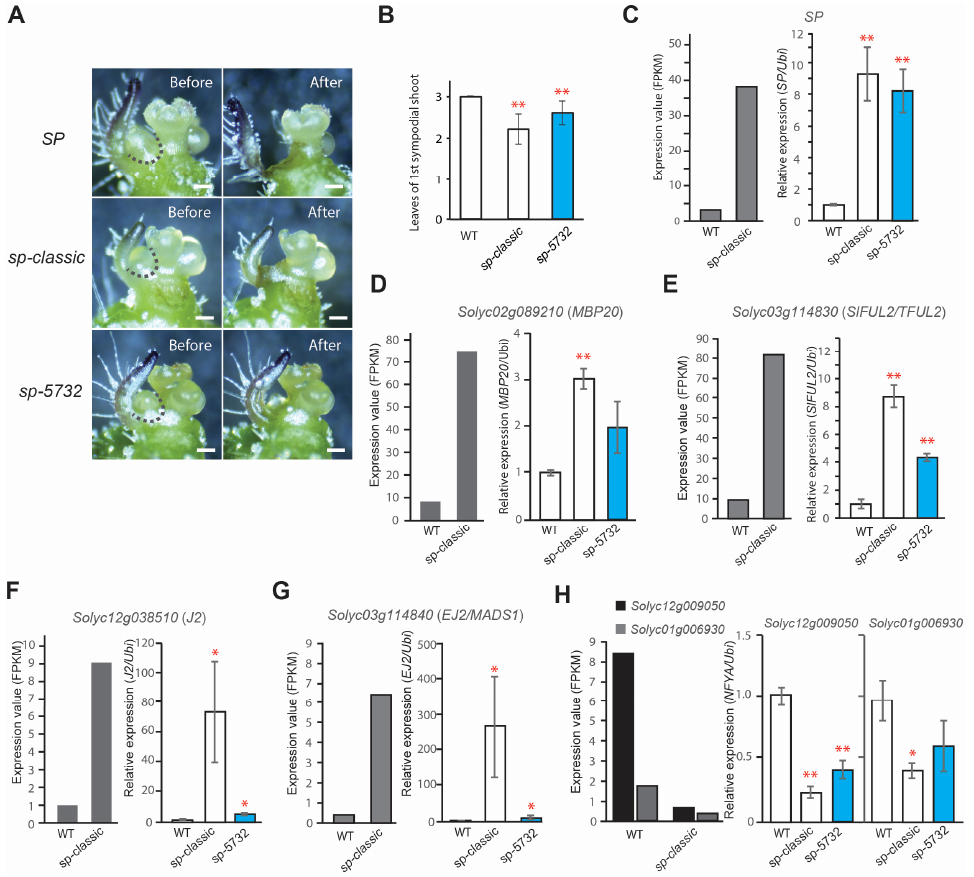
Figure 7. Quantification of molecular status of sp-5732 SYM using biomarkers. ( A ) Microdissection of SYM from SP as the indeterminate control, sp-classic as the determinate control, and sp-5732 . Dashed lines indicate dissected tissue lines on the intact SYM (Before). ‘After’ indicates the shoot apex image after SYM dissection. Scale bars, 100um. ( B ) Comparison of leaf production in the first SYM among three genotypes. ( C – H ) Comparisons of SP ( C ), MBP20 ( D ), SlFUL2 ( E ), J2 ( F ), EJ2 ( G ), and Solyc12g009050 and Soly01g006930 ( H ) expression in SYM detected by qRT-PCR. Gray bars indicate normalized read counts of each gene from tomato SYM RNA-seq data analysis. Blue bars indicate the values of leaf number and expression. Relative mRNA levels of each gene were normalized to the level of Ubiquitin mRNA. Statistical comparisons of the mean values (±s.d) were conducted with at least two biological replicates. P values were determined via two-tailed, two-sample t-test; * p < 0.05; ** p < 0.01.